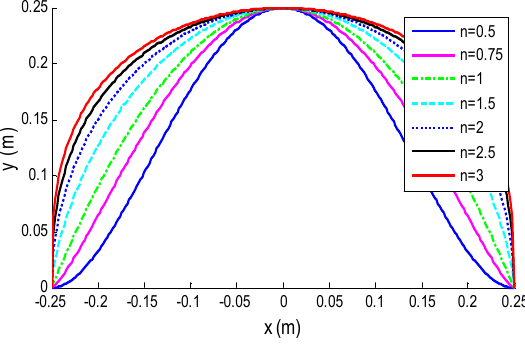
Figure 2. Blade shapes with different